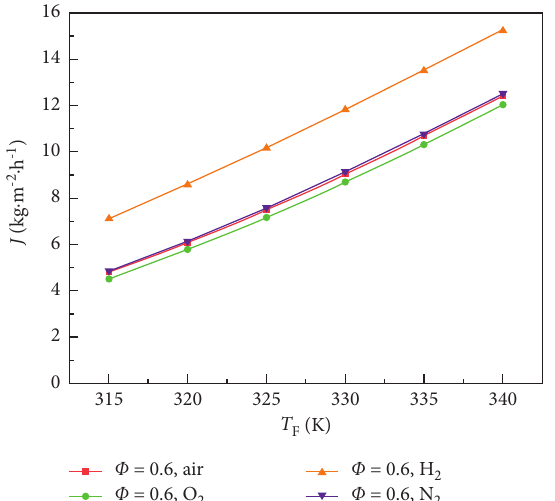
Figure 10: Permeate flux under different temperature of the feed side. T W NaCl � 0.